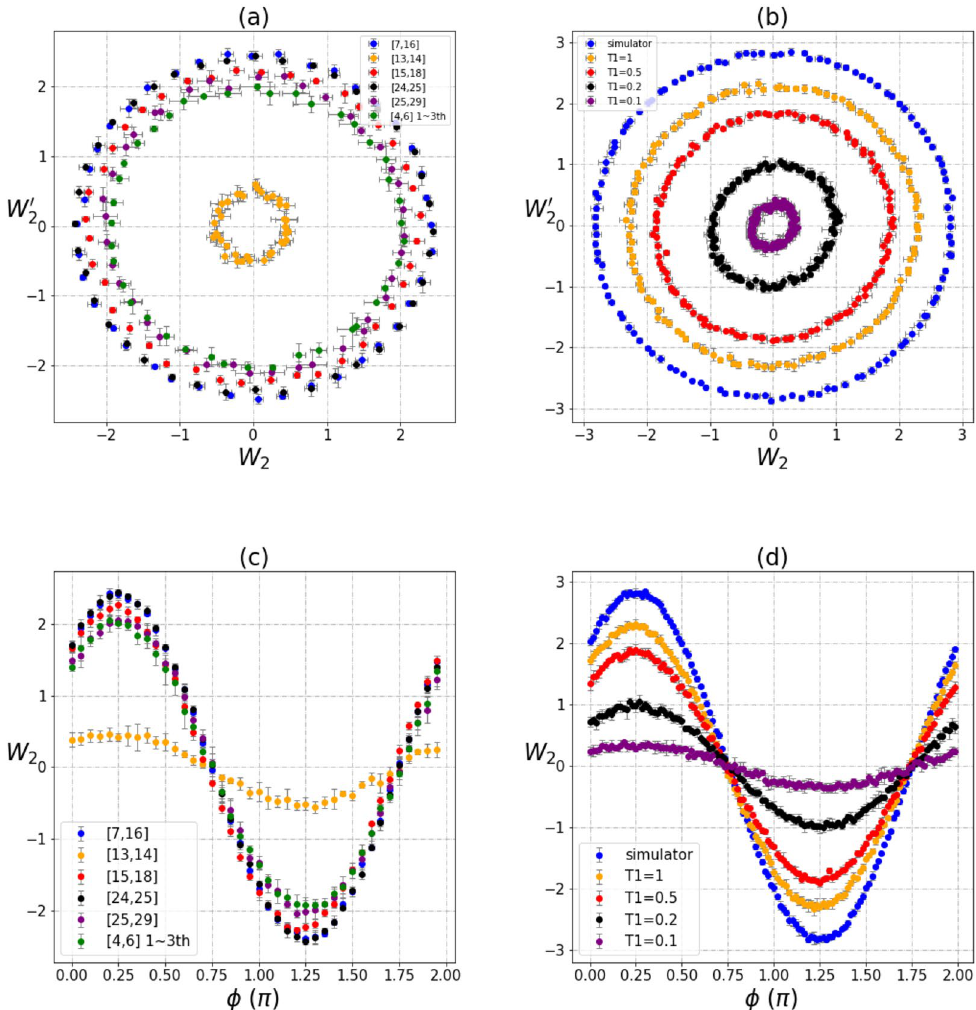
W ′ W 2 and ( a , b ) and the relationships of 2 (cid:30) (cid:31) (cid:31) (cid:30)